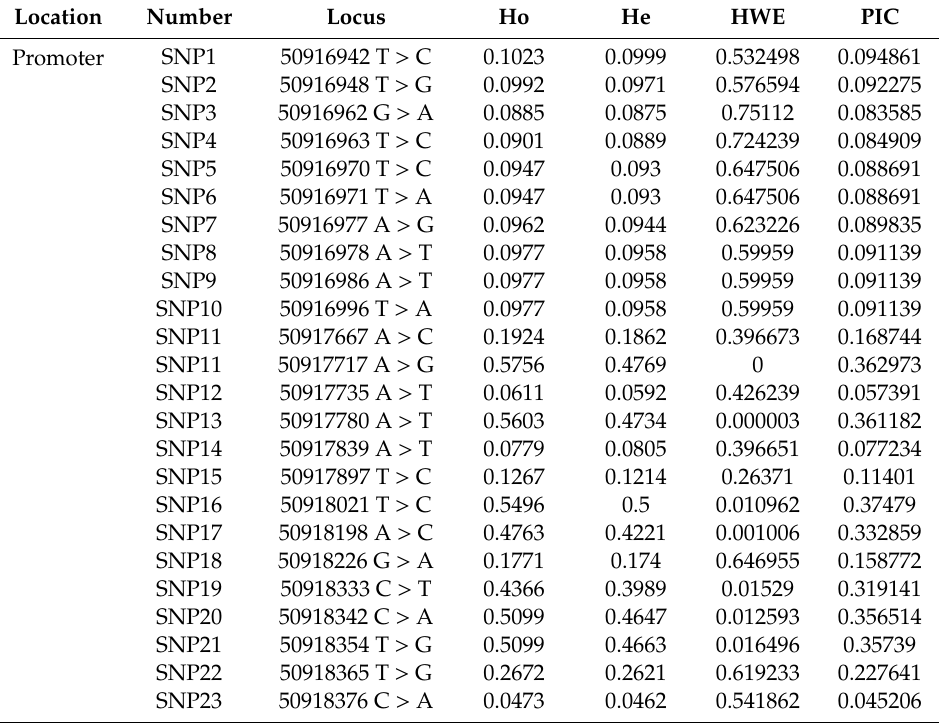
Table 2. Genetic diversity based on SNP polymorphisms in PmFGF18.